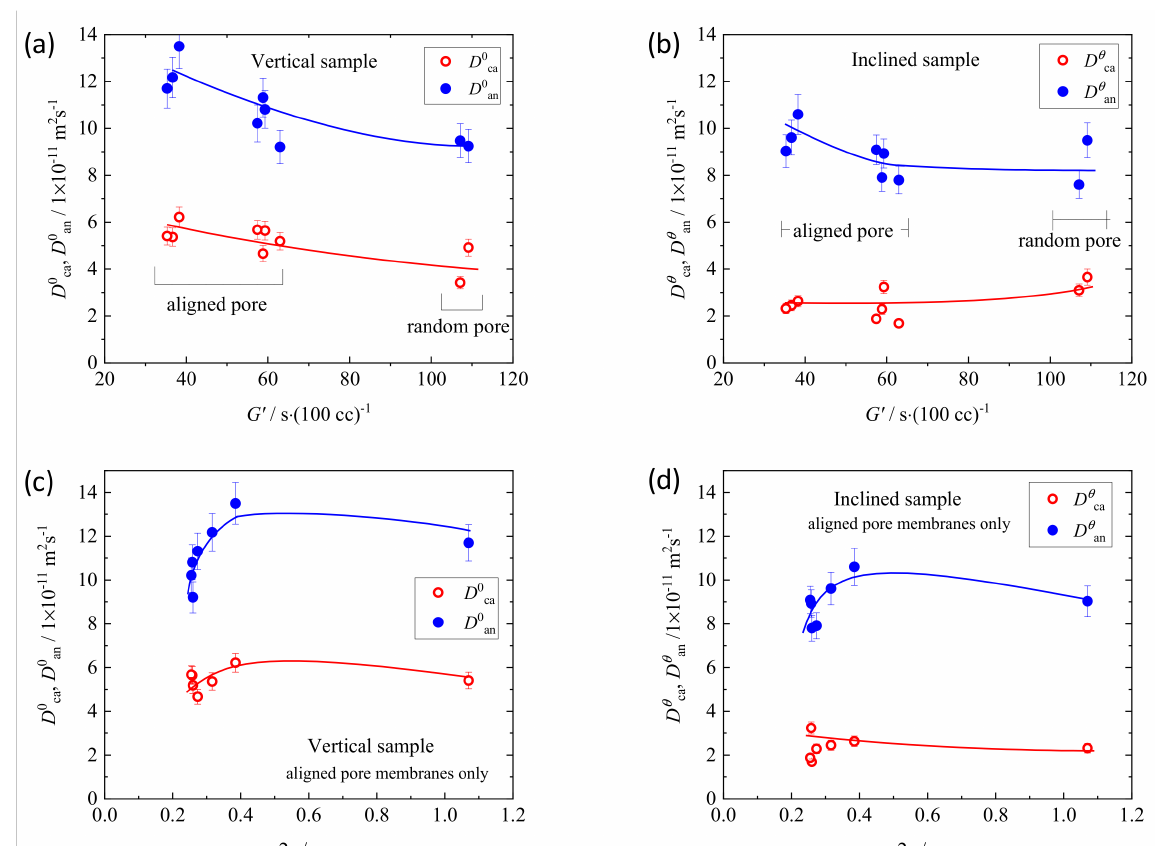
Figure 9. Estimated D ca and D an of L1 solution in ( a , c ) vertical PP membranes (identified by superscript 0) and ( b , d ) inclined PP membranes (identified by superscript θ ) as functions of ( a , b ) normalized G ( G (cid:48) ) and ( c , d ) pore diameter (= path width) (2 r ). Reprinted with permission from [37]. Copyright 2019 ACS